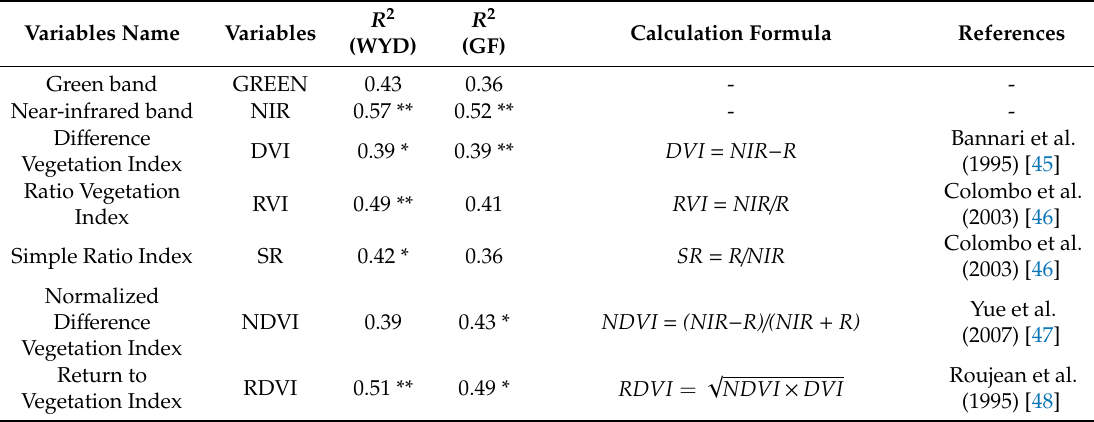
Table 3. Vegetation indexes and calculation